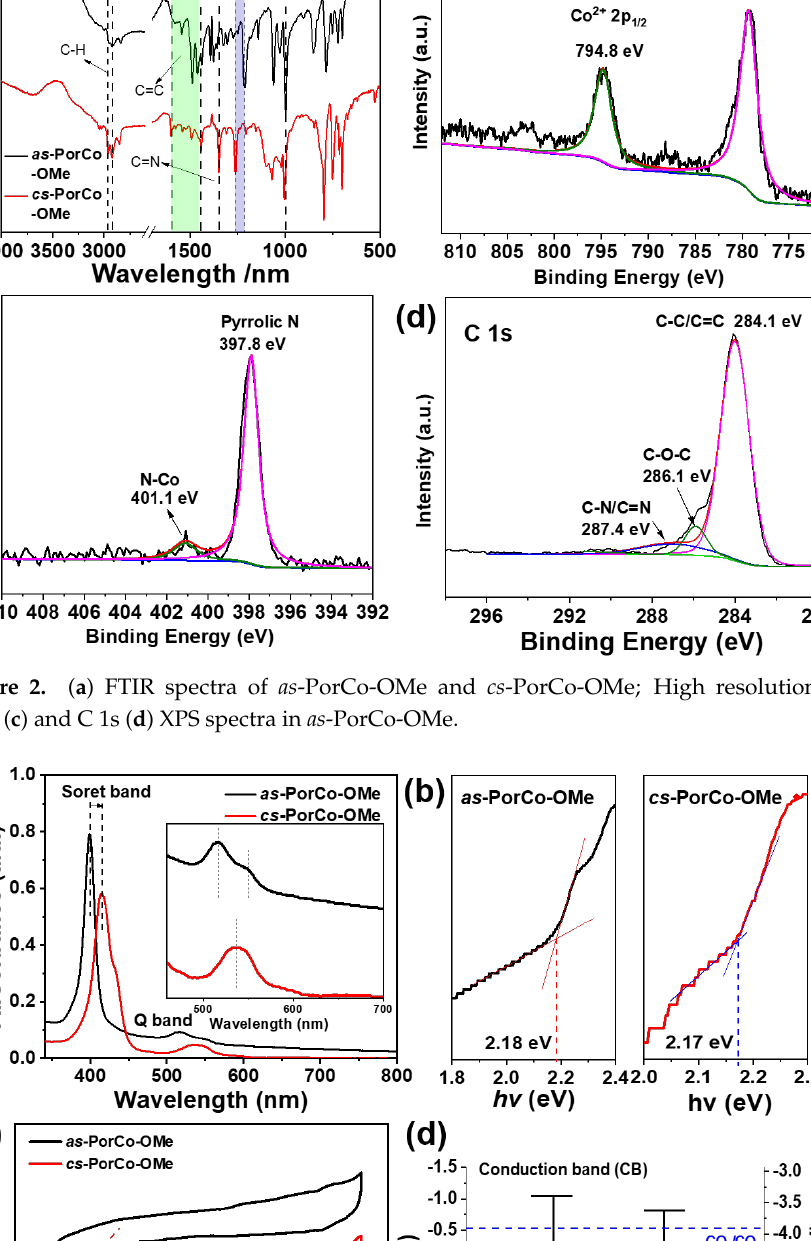
Figure 3. ( a ) UV-vis absorption spectra of as -PorCo-OMe and cs -PorCo-OMe; ( b ) bandgap of as -PorCo-OMe and cs -PorCo-OMe calculated by Tauc method; ( c ) cyclic voltammetry curves of as -PorCo-OMe and cs -PorCo-OMe; ( d ) Band structure diagram for as -PorCo-OMe and cs -PorCo-OMe.